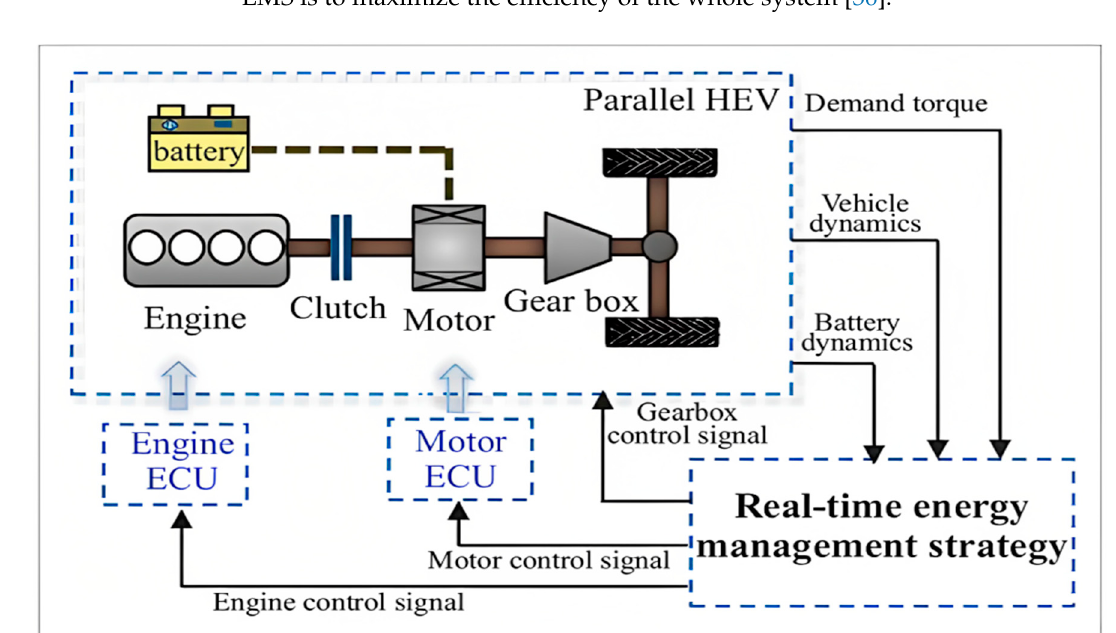
Figure 7. Powertrain architecture of a typical parallel HEV.